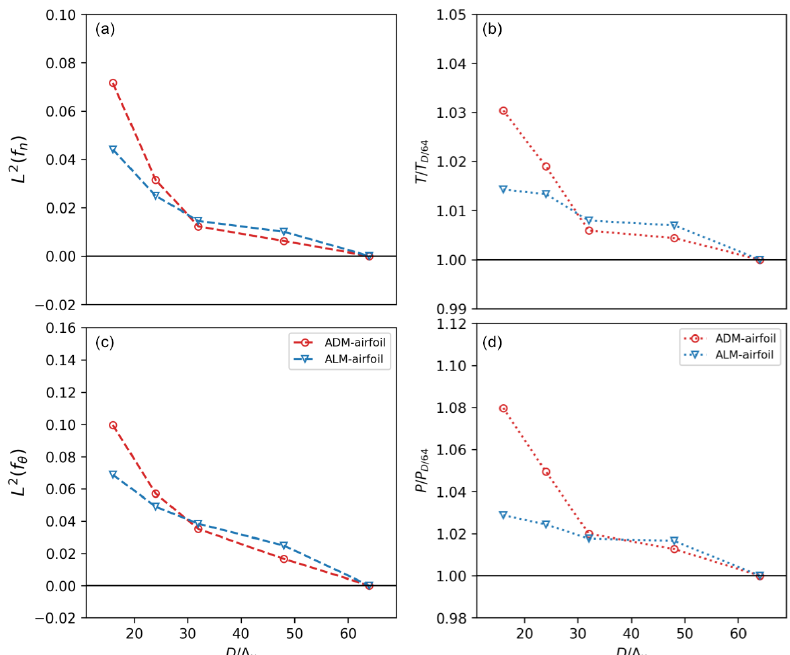
Figure A3. Mesh sensitivity study for the ADM-airfoil and the ALM-airfoil: (a, c) L2 error for the normal f n (a) and tangential f θ (c) force distributions in different mesh resolutions. The error is calculated by comparing with the distribution of the higher-resolution case. Thrust T (b) and power P (d) , where the values are divided by the value obtained with the higher resolution.